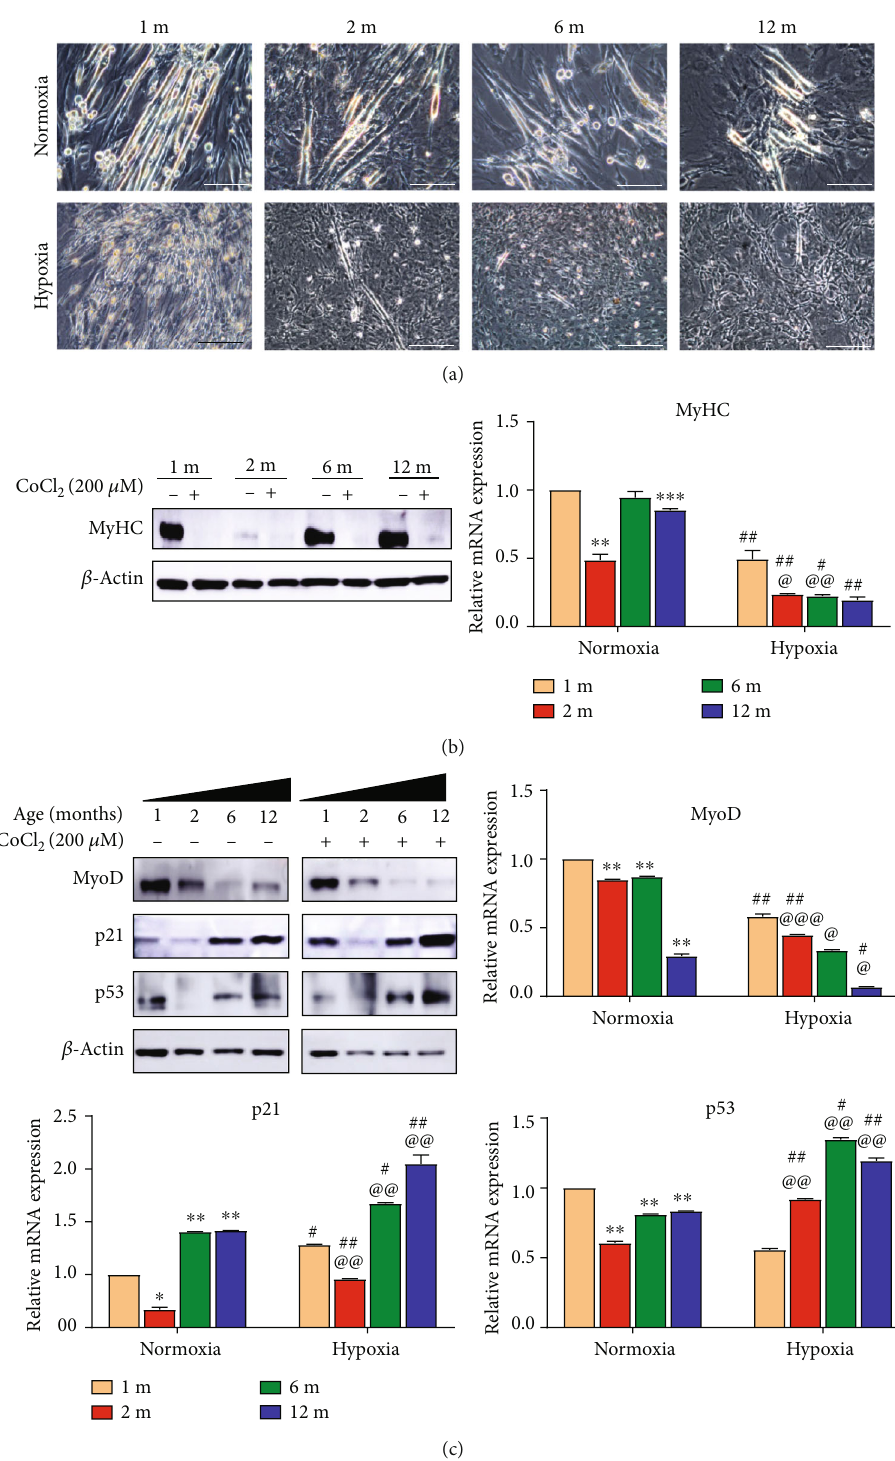
Figure 6: Hypoxia strengthened the in fl uence of aging on GG MuSC di ff erentiation. (a) The di ff erentiation of GG MuSCs from four age groups under normoxia and hypoxia. (b) The expression level of MyHC was tested after di ff erentiation in normoxia and hypoxia. (c) p53, p21, and MyoD were observed after di ff erentiation under normoxia and hypoxia. p53 and p21 signi fi cantly increased, and the expressions of MyHC and MyoD were markedly downregulated under hypoxia. Aging further inhibited the levels of MyHC and MyoD and increased the levels of p53 and p21. Statistical signi fi cance is marked as follows: ∗ represents the di ff erence between normoxia and 1-month-old vs. 2-month-old vs. 6-month-old vs. 12-month-old; ∗ p < 0 : 05 , ∗∗ p < 0 : 01 , and ∗∗∗ p < 0 : 001 . @ represents the di ff erence between hypoxia and 1-month-old vs. 2-month-old vs. 6-month-old vs. 12-month-old; @ p < 0 : 05 , @@ p < 0 : 01 , and @@@ p < 0 : 001 . # represents the di ff erence between same age and normoxia vs. hypoxia; # p < 0 : 05 , ## p < 0 : 01 , and ### p < 0 : 001 . Scale bars are 100 μ m in all images. Scale bars are 100 μ